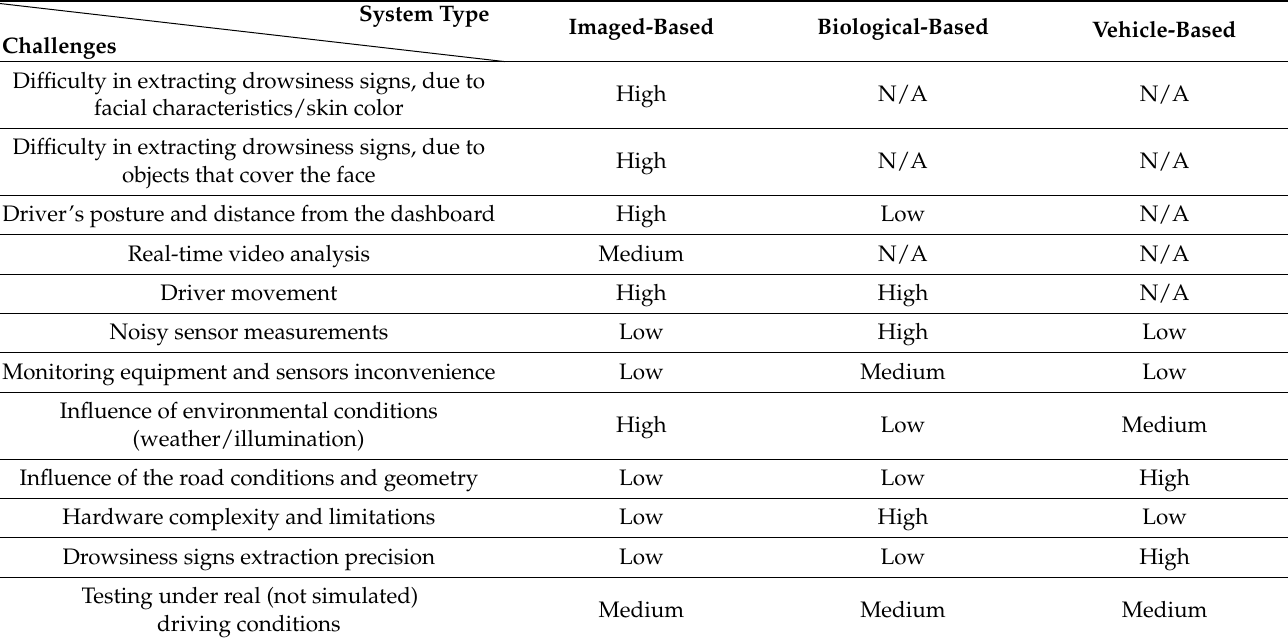
Table 9. DDD systems